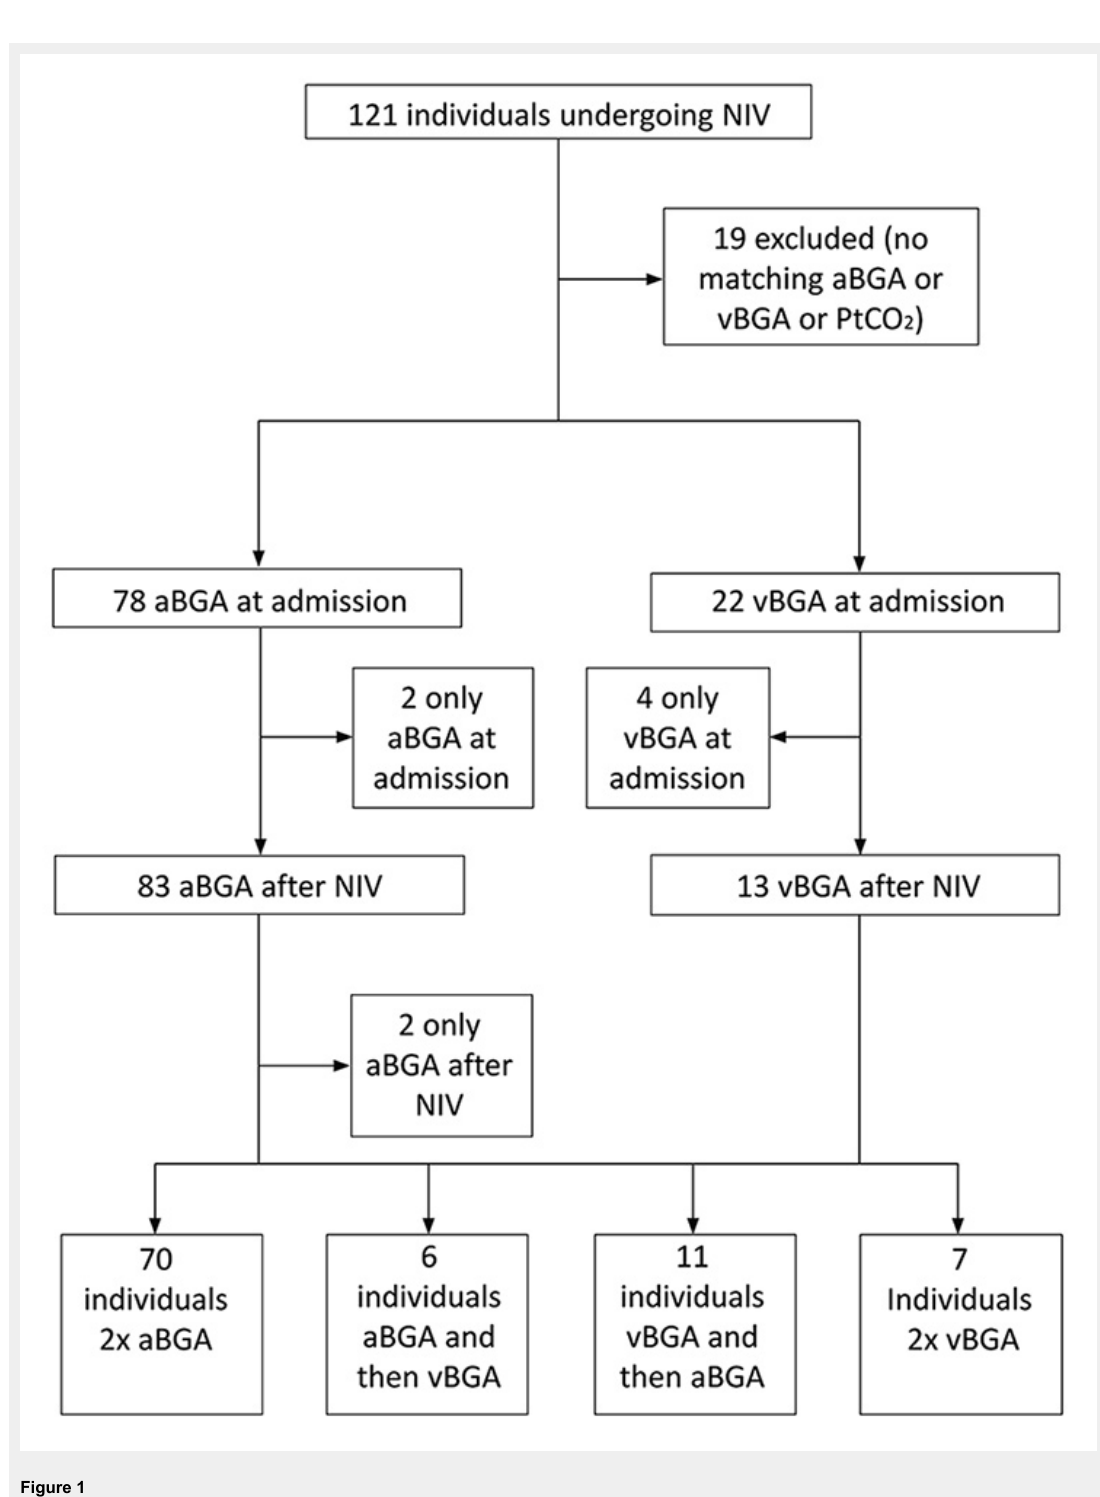
Figure 1 Study flow diagram. aBGA = arterial blood gas analysis; NIV = noninvasive ventilation; PtCO 2 = transcutaneous partial pressure of CO 2 ; vBGA = venous blood gas